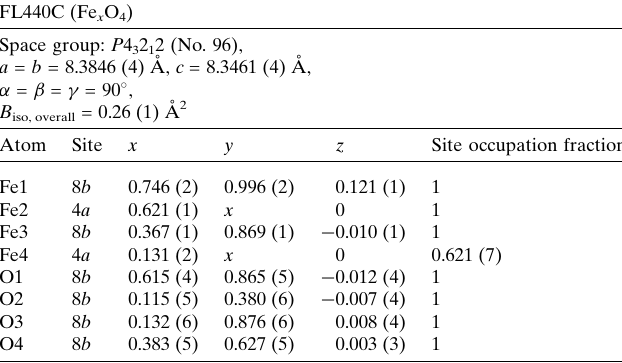
Table 1 The atomic structural model in tetragonal space group P 4 3 2 1 2 [as reported by Greaves (1983)] employed in the refinement of the FL440C sample. The corresponding refined parameters for the FL340C and FL390C samples may be found in the Supporting information. The numbers in parentheses indicate the errors on the last significant digit of the refined parameters. The secondary hematite phase (space group R 3 c ) was found to constitute 0.7 (5) wt%. B iso,overall is a common isotropic atomic displacement parameter refined for all